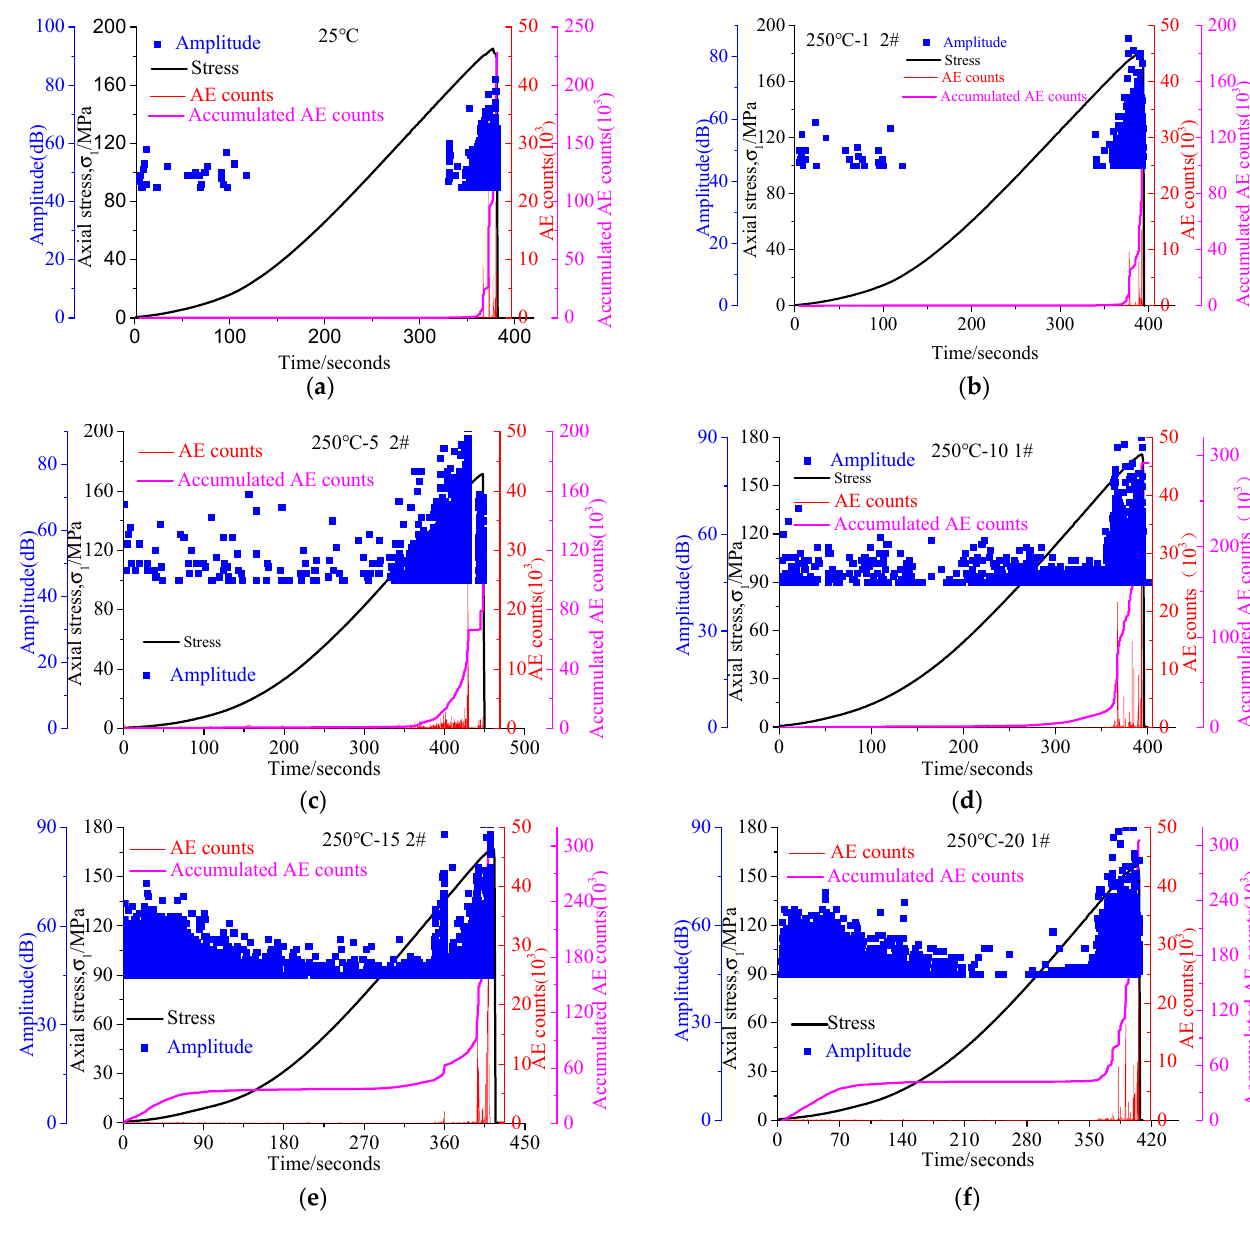
Figure 6. Changes in acoustic emission characteristic parameters during uniaxial compression of specimens after repeated treatment at 250 °C. ( a ) 25 °C. ( b ) 250 °C-1. ( c ) 250 °C-5. ( d ) 250 °C-10. ( e ) 250 °C-15. ( f ) 250 °C-20.